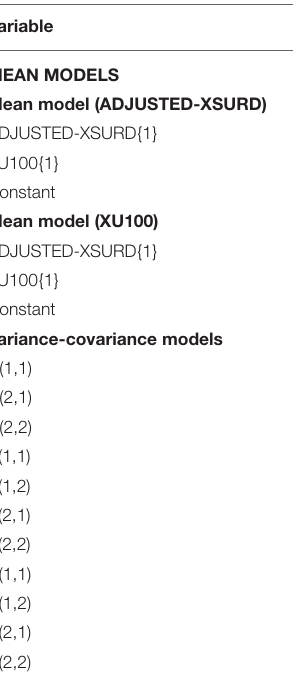
TABLE 1 | Descriptive statistics of XSURD and BIST 100 return series.